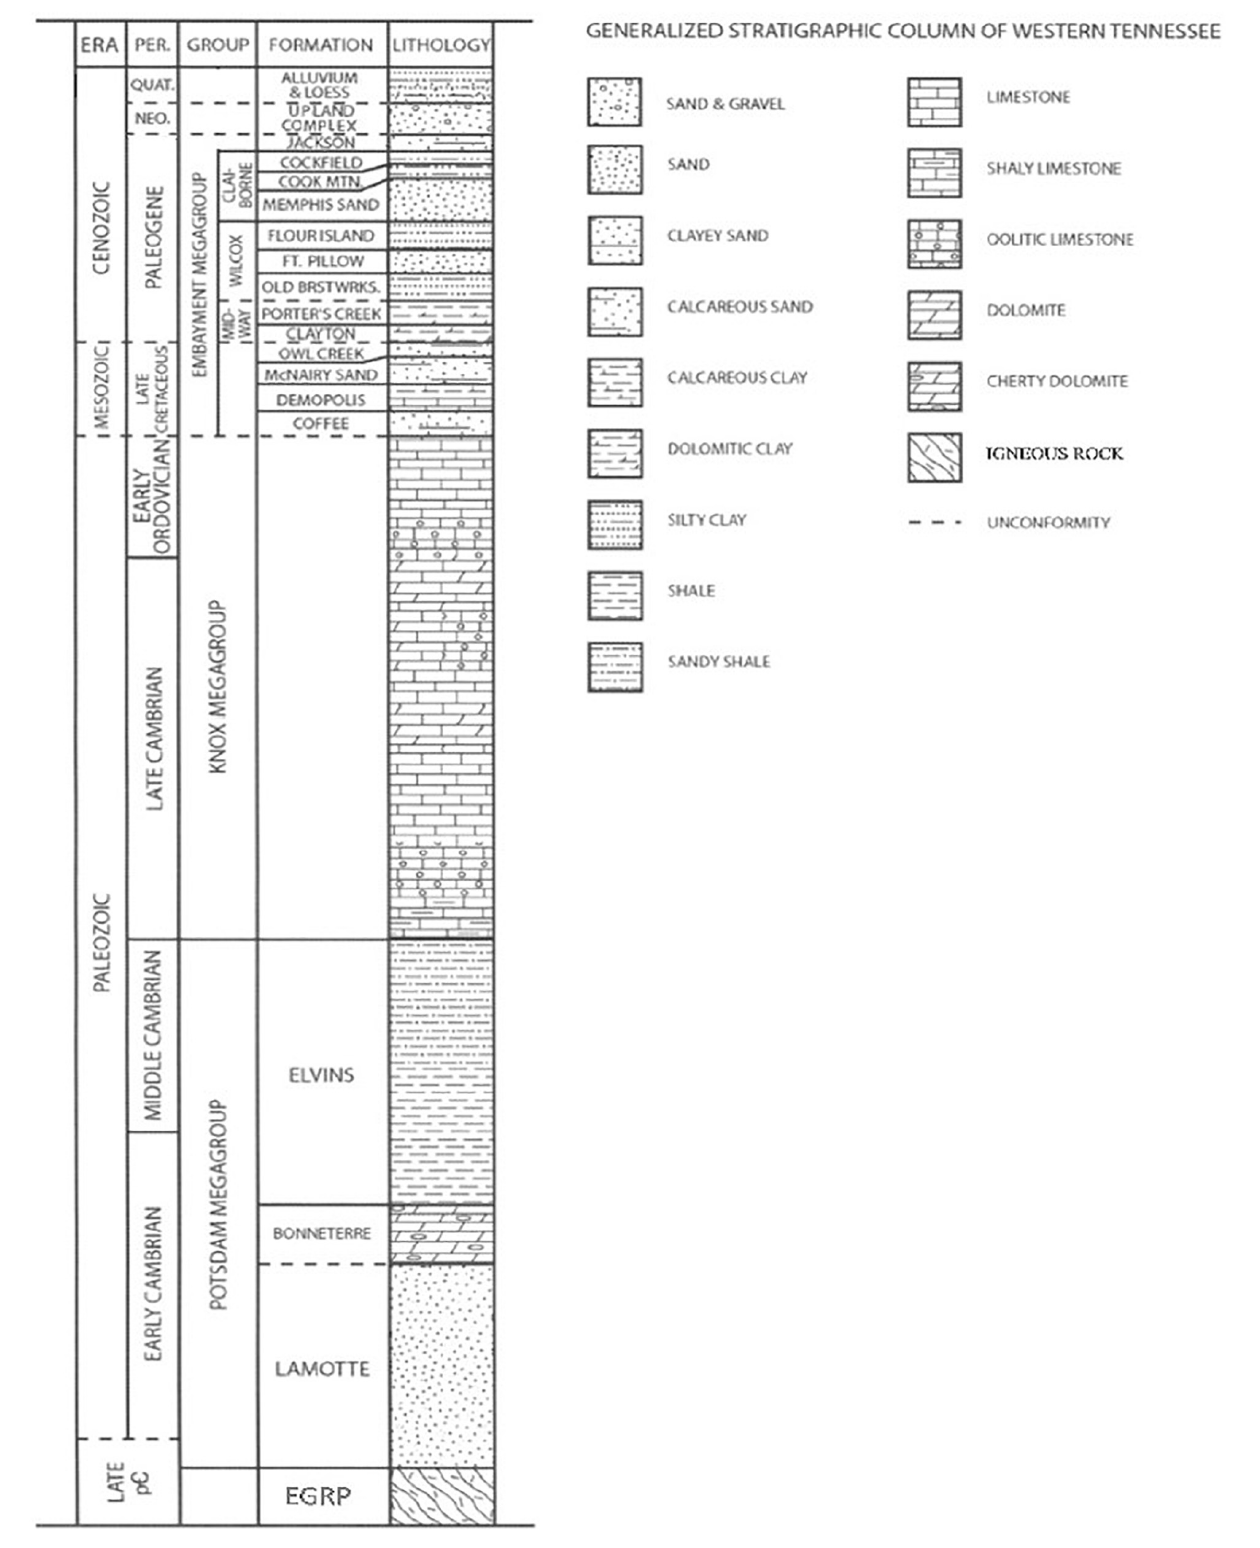
FIGURE 4 | Generalized stratigraphic column of West Tennessee. Quat., Quaternary; Neo., Neogene; EGRP, Eastern Granite-Rhyolite Province [modified from Parrish and Van Arsdale (2004) and Ward (2016)].